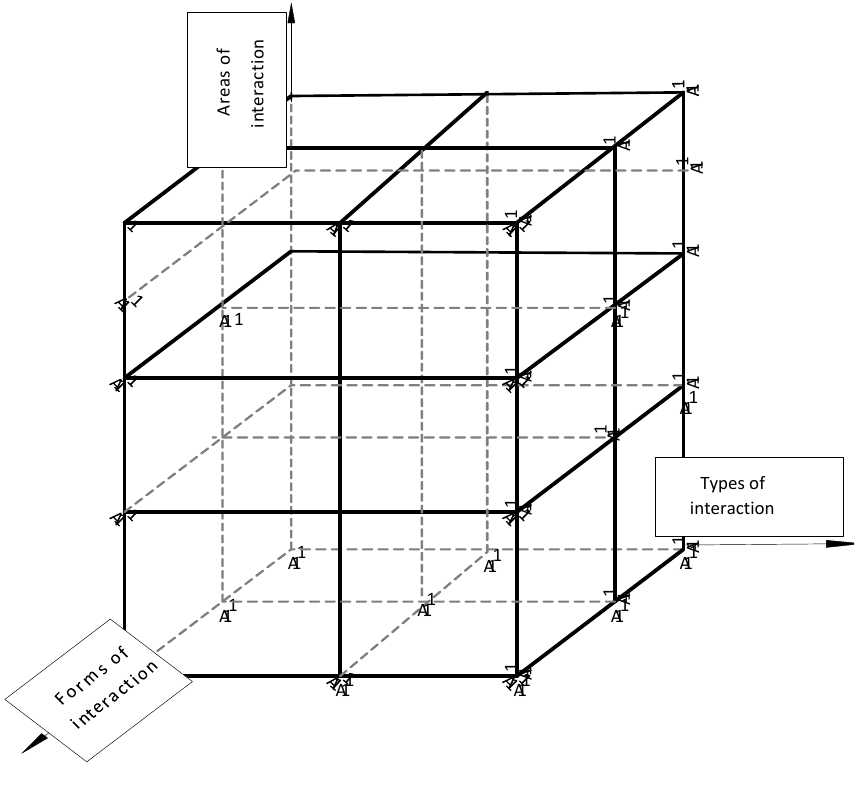
Figure 5. Three-component model for choosing the form of interaction between the university and